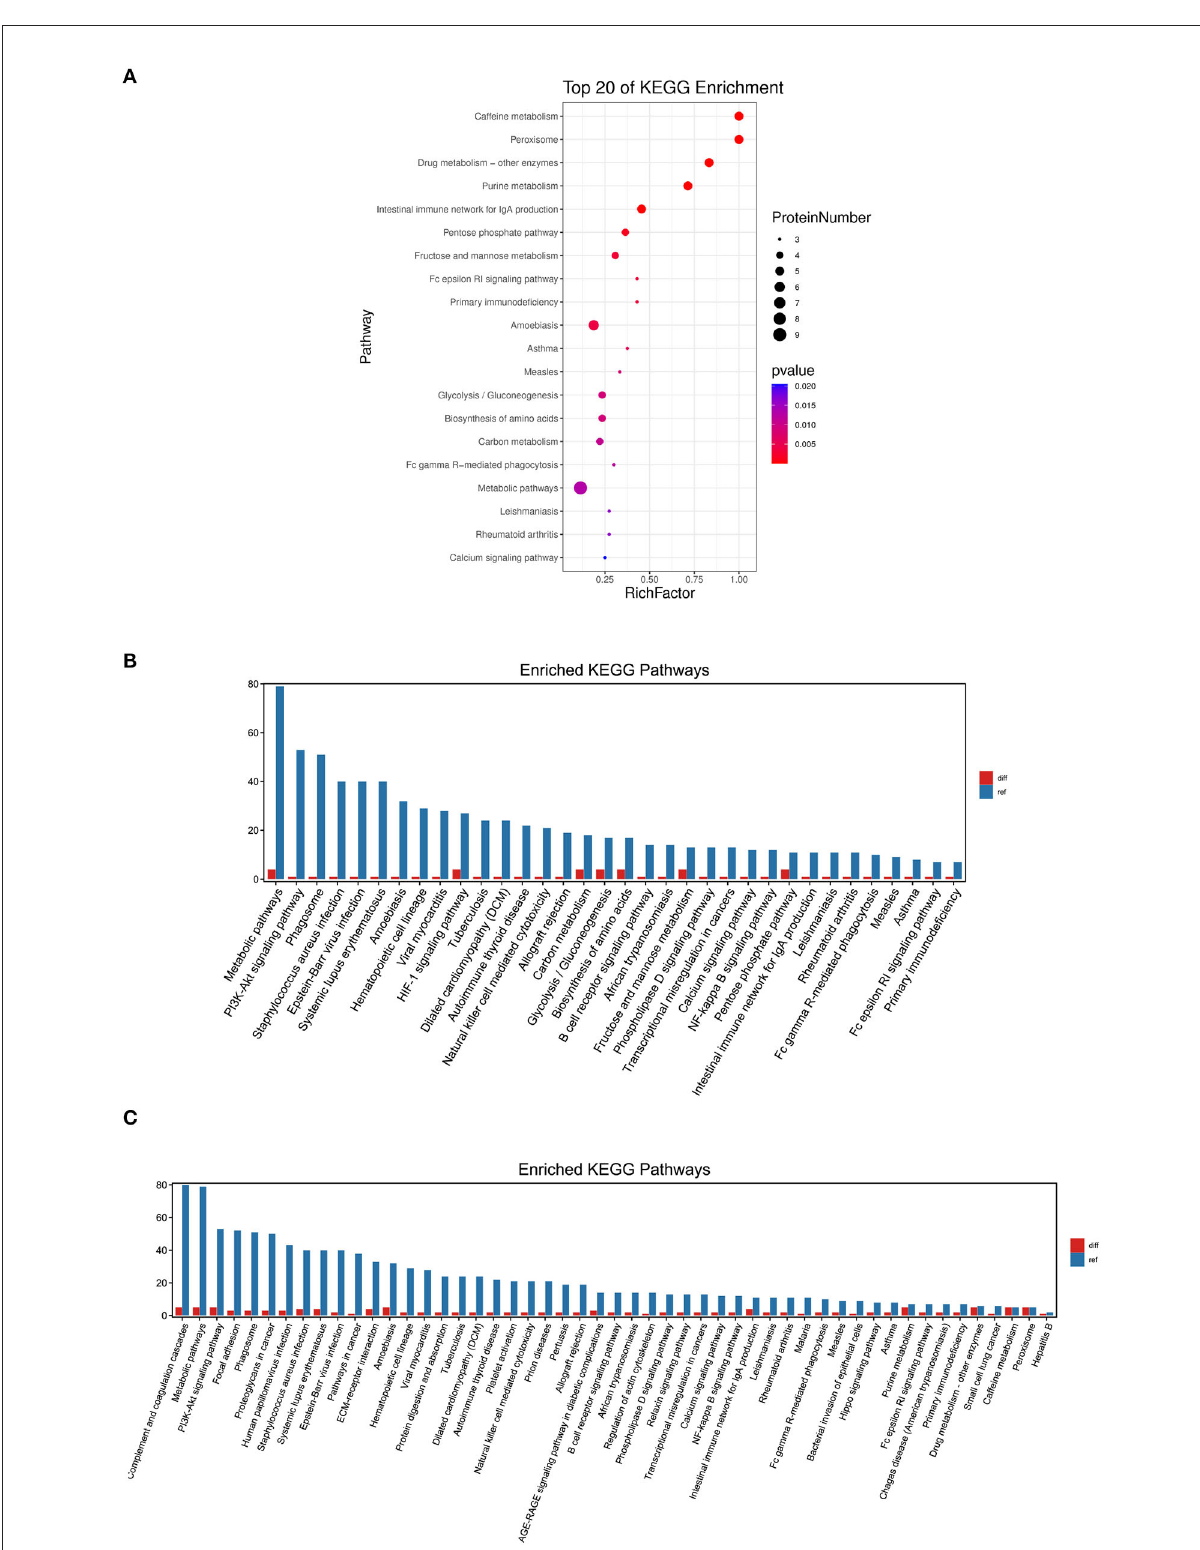
FIGURE4 KEGG pathway enrichment analysis of the differentially expressed proteins. (A) The first 20 pathways with the lowest P -value were used for the diagram, with the ordinate as pathways and the abscissa as enrichment factors (The number of differential proteins in that pathway divided by the number of all proteins. The size indicated the number of different proteins, and the more red the color, the smaller the P -value). (B) KEGG enrichment analysis of the significantly increased proteins. (C) KEGG enrichment analysis of the significantly decreased